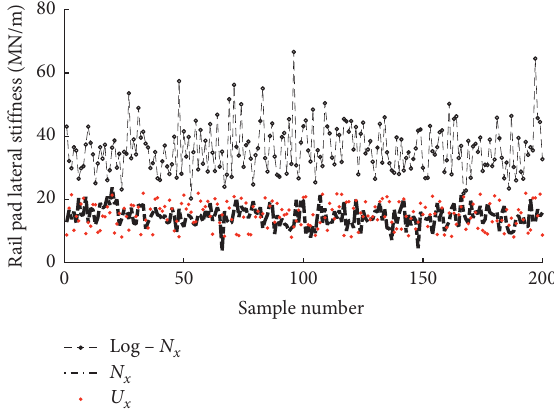
Figure 9: The lateral stiffness of 200 samples for a specific rail